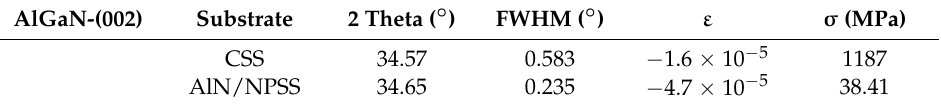
Table 1. Strain ( ε ) and stress ( σ ) of the AlGaN layer grown on CSS or